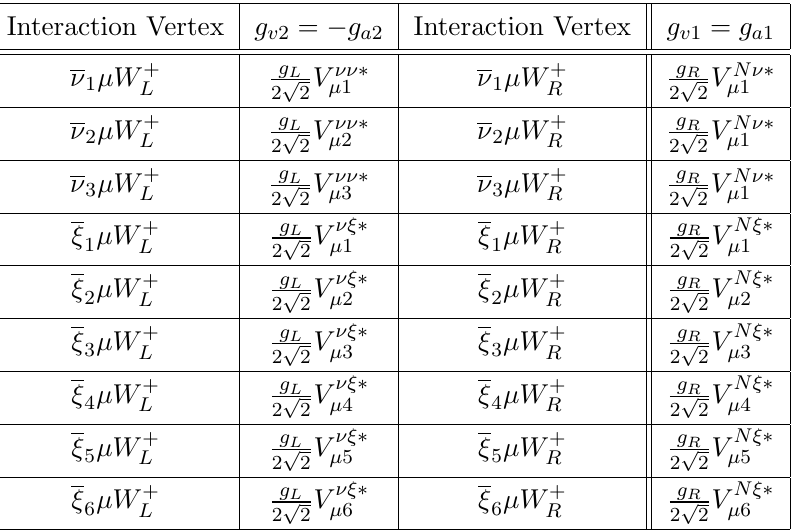
Table 3 . Relevant vector and axial vector couplings for muon with W L ; W R gauge bosons and physical neutral fermion states within the inverse seesaw (ISS)